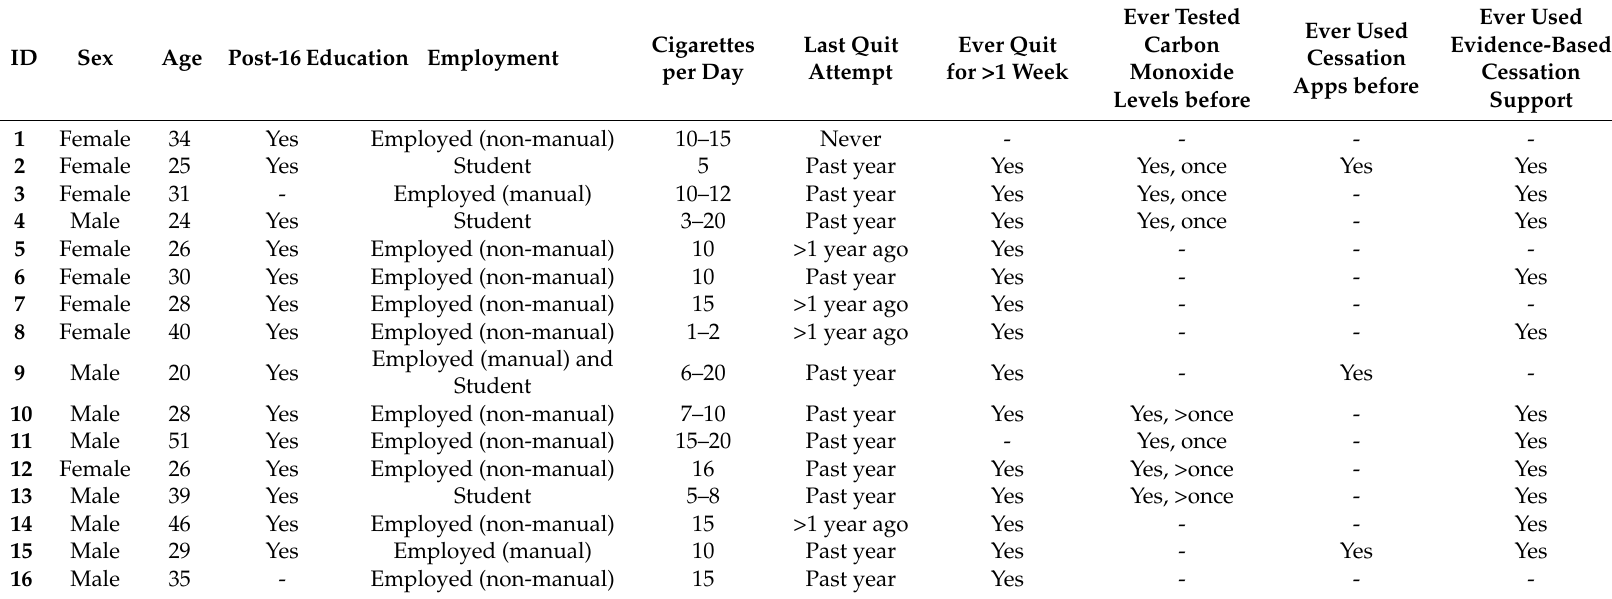
Table 1. Characteristics of the interviewed